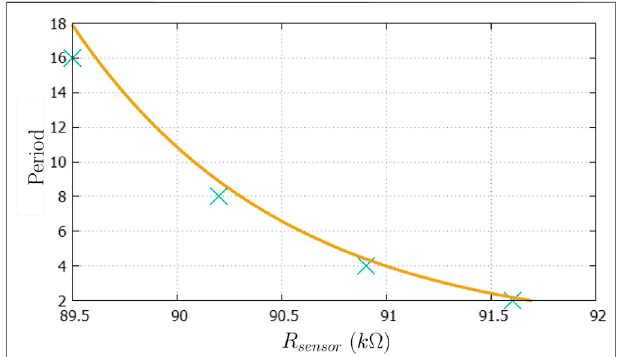
FIGURE4| Curveadjustmentof Eq.7 totheexperimentaldatashownin Table 1 .